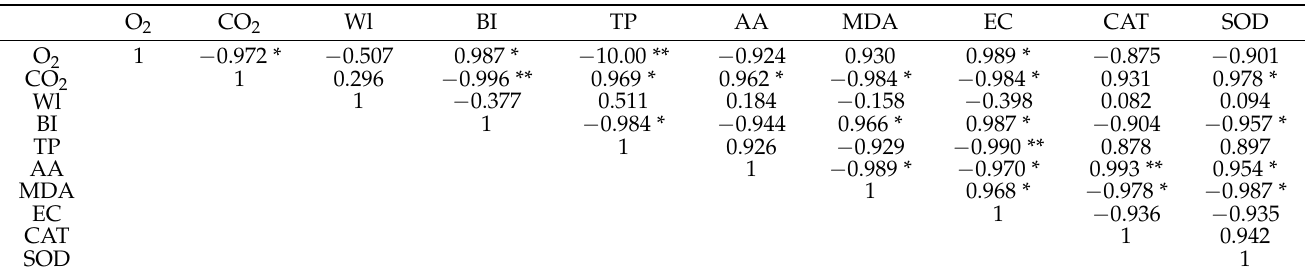
Table 4. Correlation analysis between gas composition in packing and postharvest quality of Agaricus bisporus